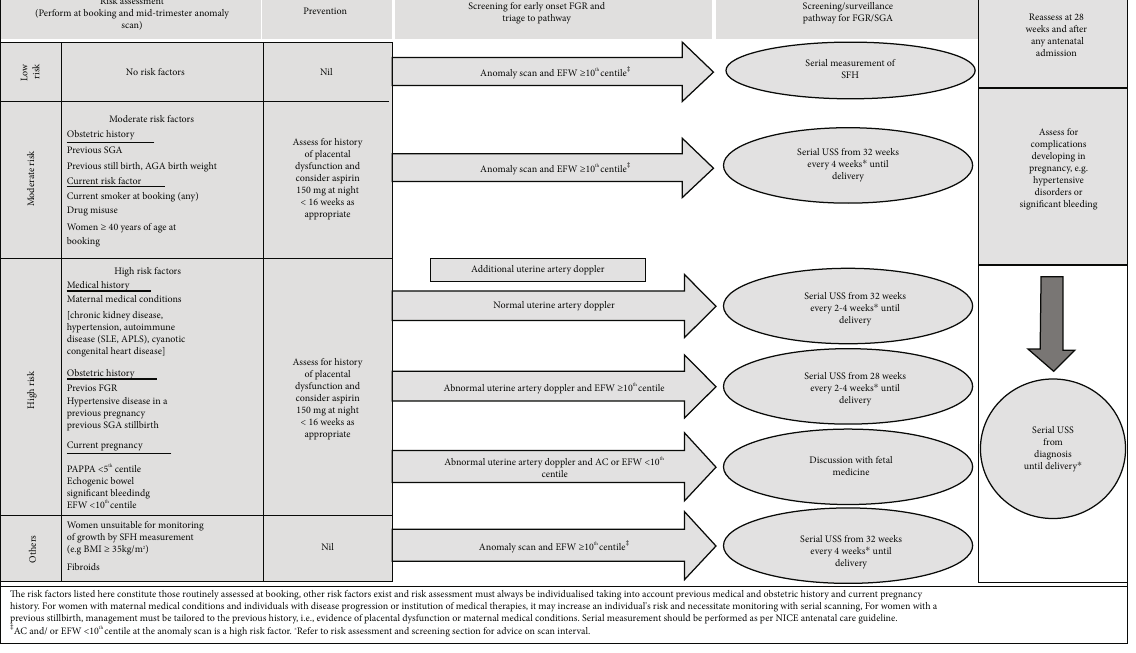
Figure 1: Algorithm describing uterine artery Doppler as a screening tool for risk of early-onset FGR [1]. Table 1: E ff ect of hospital location on demographic and outcome